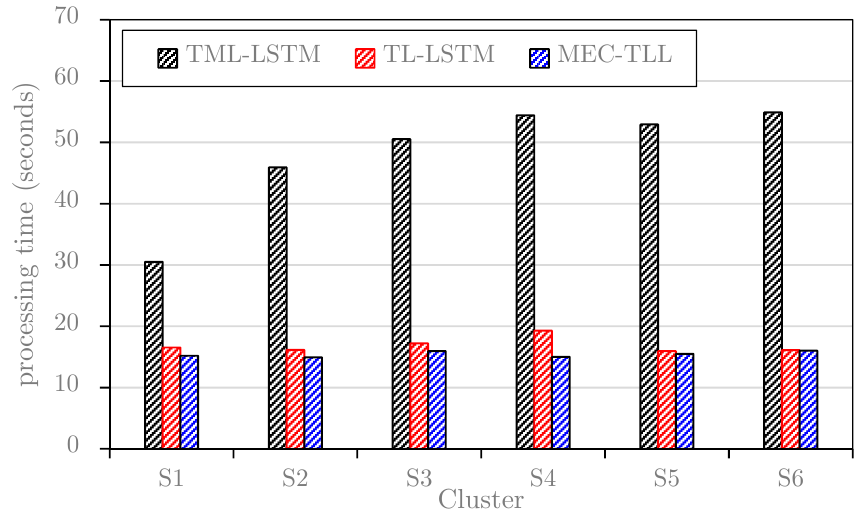
Figure 10. The computational time of each cluster on the B2 dataset. Table 1. Performance results of the experimental methods on the B1 dataset.